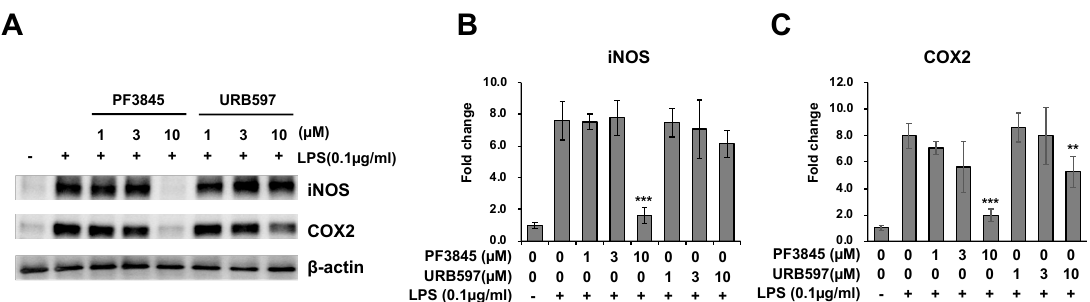
Figure 3. Expression of iNOS and COX-2 after FAAH inhibitor treatment. BV2 cells were treated with LPS and FAAH inhibitor for 18 h. The cell lysate was employed for western blotting with β -actin, iNOS, and COX-2 antibodies ( A ). Protein expression levels were assessed by quantifying band intensity, and relative expression to β -actin is shown in ( B ) for iNOS and in ( C ) for COX-2. The + and – symbols indicate the presence or absence, respectively, of LPS. Data are presented as means ± S.D. (n = 3). ** and *** denote p < 0.01 and p < 0.001, respectively.